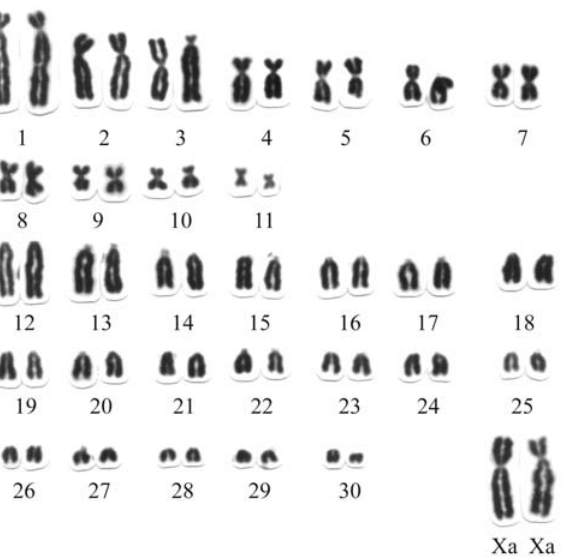
Figure2 -Conventionalstainedkaryotypeof Oligoryzomysnigripes (2n= 62/FN = 80). Pair 3 is heteromorphic and the X chromosomes are large submetacentrics (XaXa).